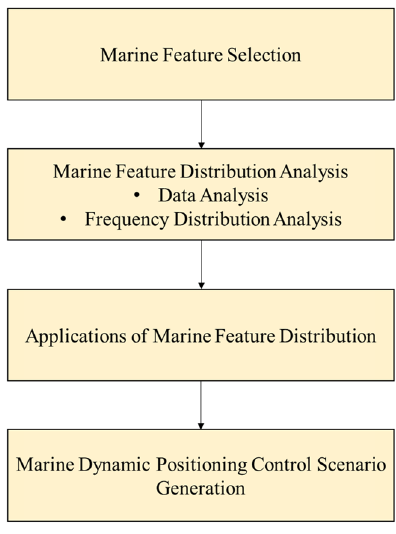
Figure 1: Elements of dynamic positioning